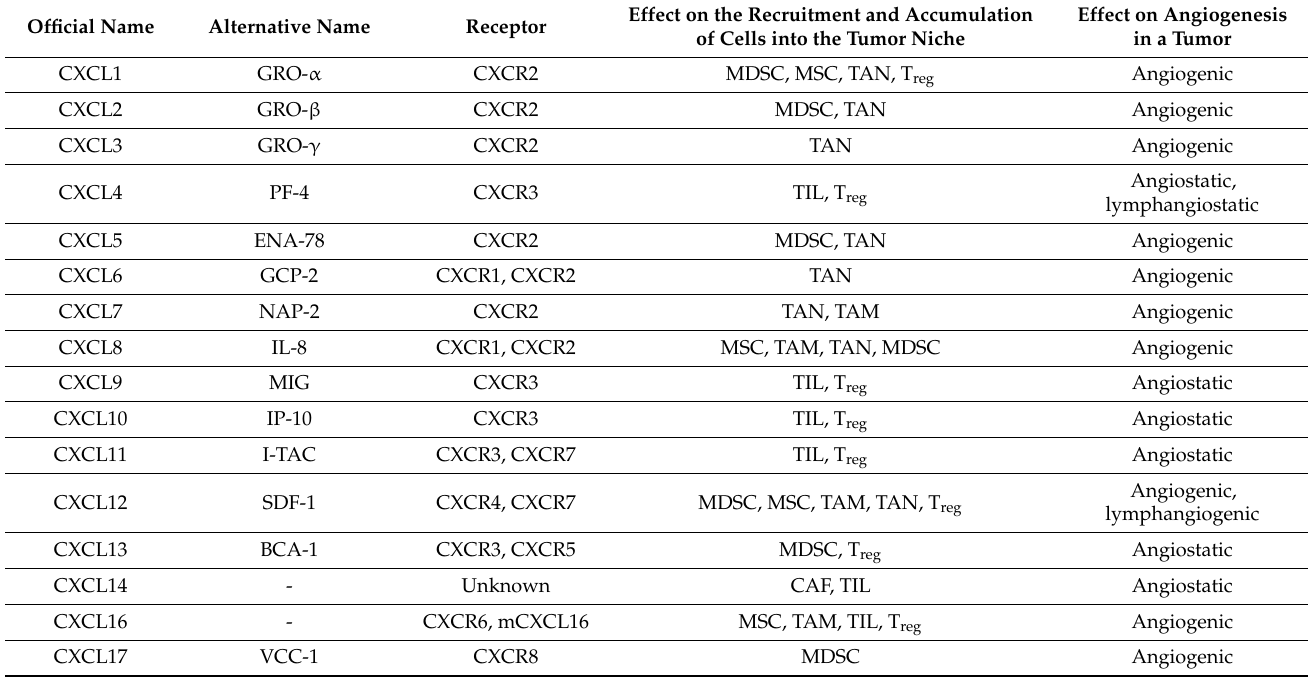
CAFs—cancer-associated fibroblasts; mCXCL16—membrane form CXCL16; MDSCs—myeloid-derived suppressor cells; MSCs— mesenchymal stem cells; TAMs—tumor-associated macrophages; TANs—tumor-associated neutrophils; T regs —regulatory T cells; TILs- tumor-infiltrating